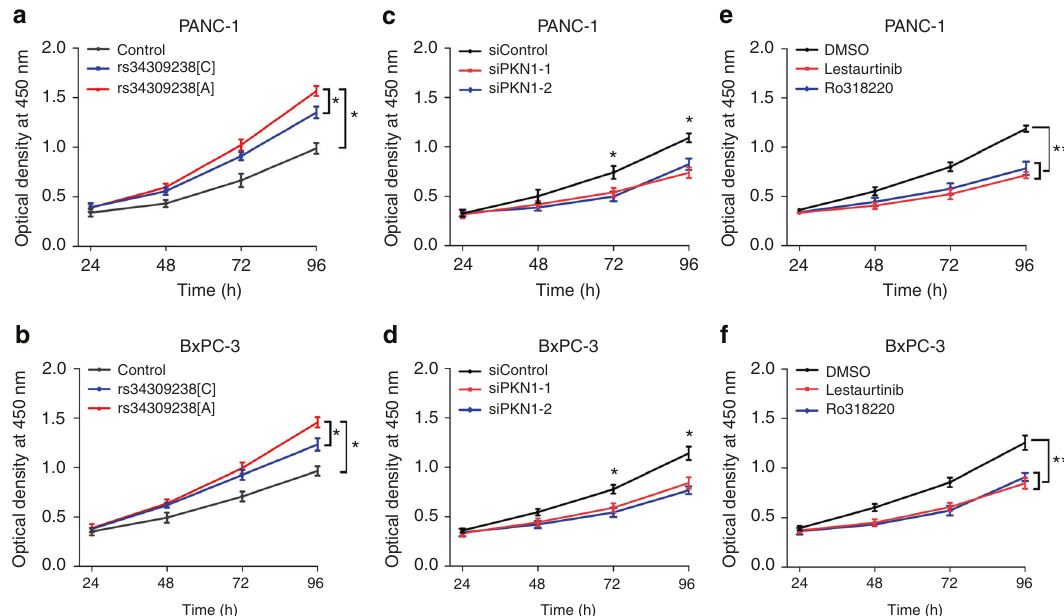
Fig. 3 PKN1 rs34309238 variant in fl uences pancreatic cancer cells' proliferation. a , b Overexpression of PKN1[A] substantially enhanced the rate of cell proliferation in PANC-1 ( a ) and BxPC-3 ( b ) cells. Cells were seeded in 96-well plates after transfection with PKN1[A], PKN1[C] or control vector. c , d Knockdown of PKN1 signi fi cantly reduced the proliferation of PANC-1 ( c ) and BxPC-3 ( d ) cells. Cells were seeded in 96-well plates after transfection with PKN1-targeting siRNAs or control siRNA (siControl). e , f PKN1 inhibitors signi fi cantly reduced the rate of cell proliferation in PANC-1 ( e ) and BxPC-3 ( f ) cells. Cells were seeded in 96-well plates after transfection with PKN1 inhibitors Lestaurtinib and Ro318220 or DMSO as control. For a – f , cell numbers were determined every 24 h for 96 h using CCK-8 assays and the results present means± s.e.m. from three independent experiments and each had six replications. * P < 0.05, ** P < 0.01, compared with the control by two-sided unpaired Student ’ s t